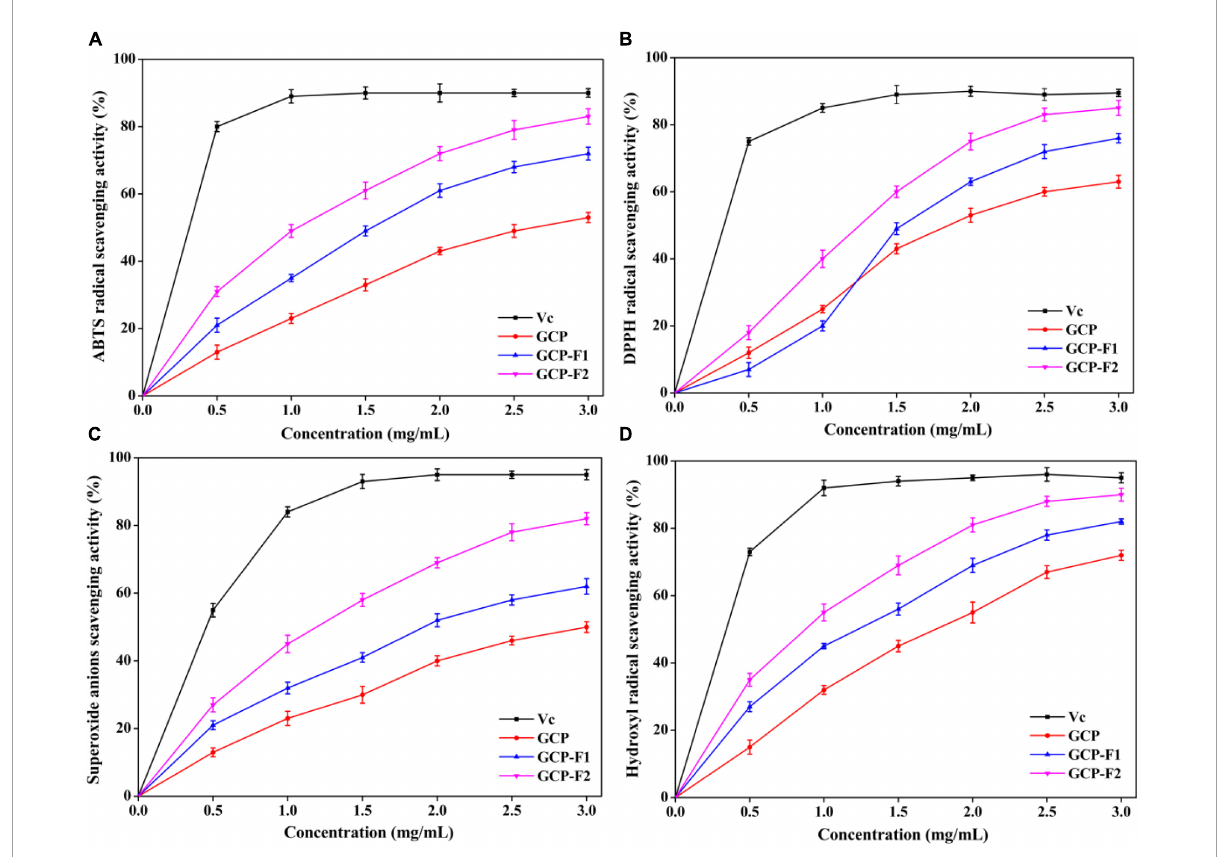
FIGURE4 Scavenging effects of GCP, GCP-F1, and GCP-F2 on 2,2 (cid:48) -azinobis-(3-ethylbenzothiazoline-6-sulfonic acid (ABTS) radical (A) , 2,2-diphenyl-1-picrylhydrazyl (DPPH) radical (B) , superoxide anions (C) , and hydroxyl radical (D) .